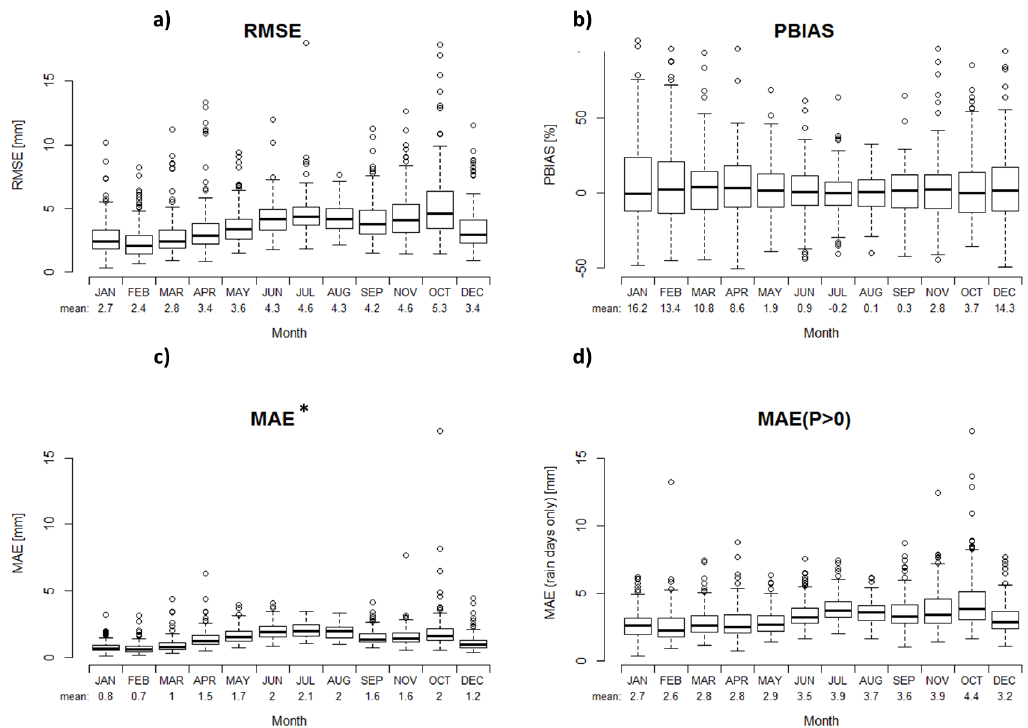
Figure 4. Evaluation of interpolation performance at monthly scale, boxplots result from mean results at each observation station over the Adige catchment. Four indicators presented: RMSE ( a ); PBIAS ( b ); MAE* ( c ); and MAE ( d ).